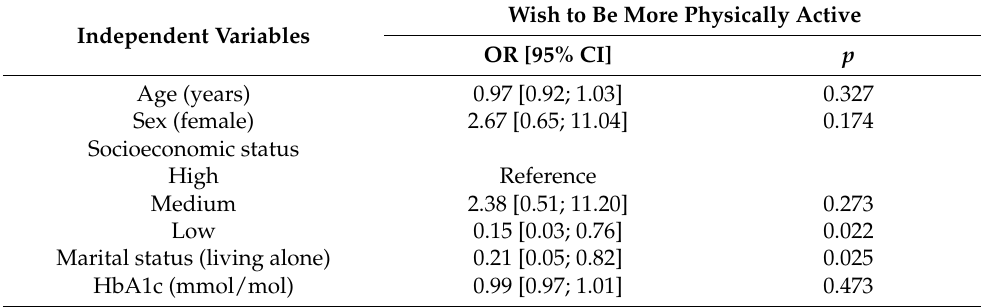
Table 4. Multiple logistic regression model with the associations between the independent variables: socioeconomic status, marital status, HbA1c, age, sex and the dependent variable ‘wish to be more physically active during admission’. Independent